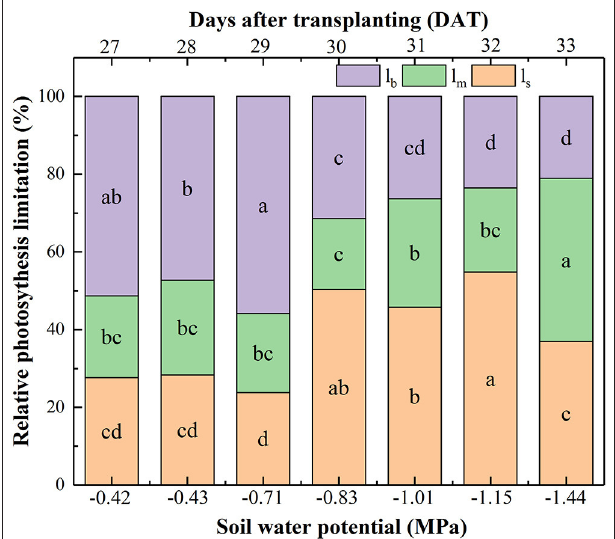
FIGURE 3 | Effect of soil water potential ( Ψ soil ) on the relative contribution of the photosynthesis capacity limiting factors: limitations of A n resulting from g s (l s ), g m (l m ), and biochemical photosynthetic capacity (l b ) after transplanting. Data were means. Different letters indicated statistically significant difference between well-watered (CK) and drought plants at P < 0.05